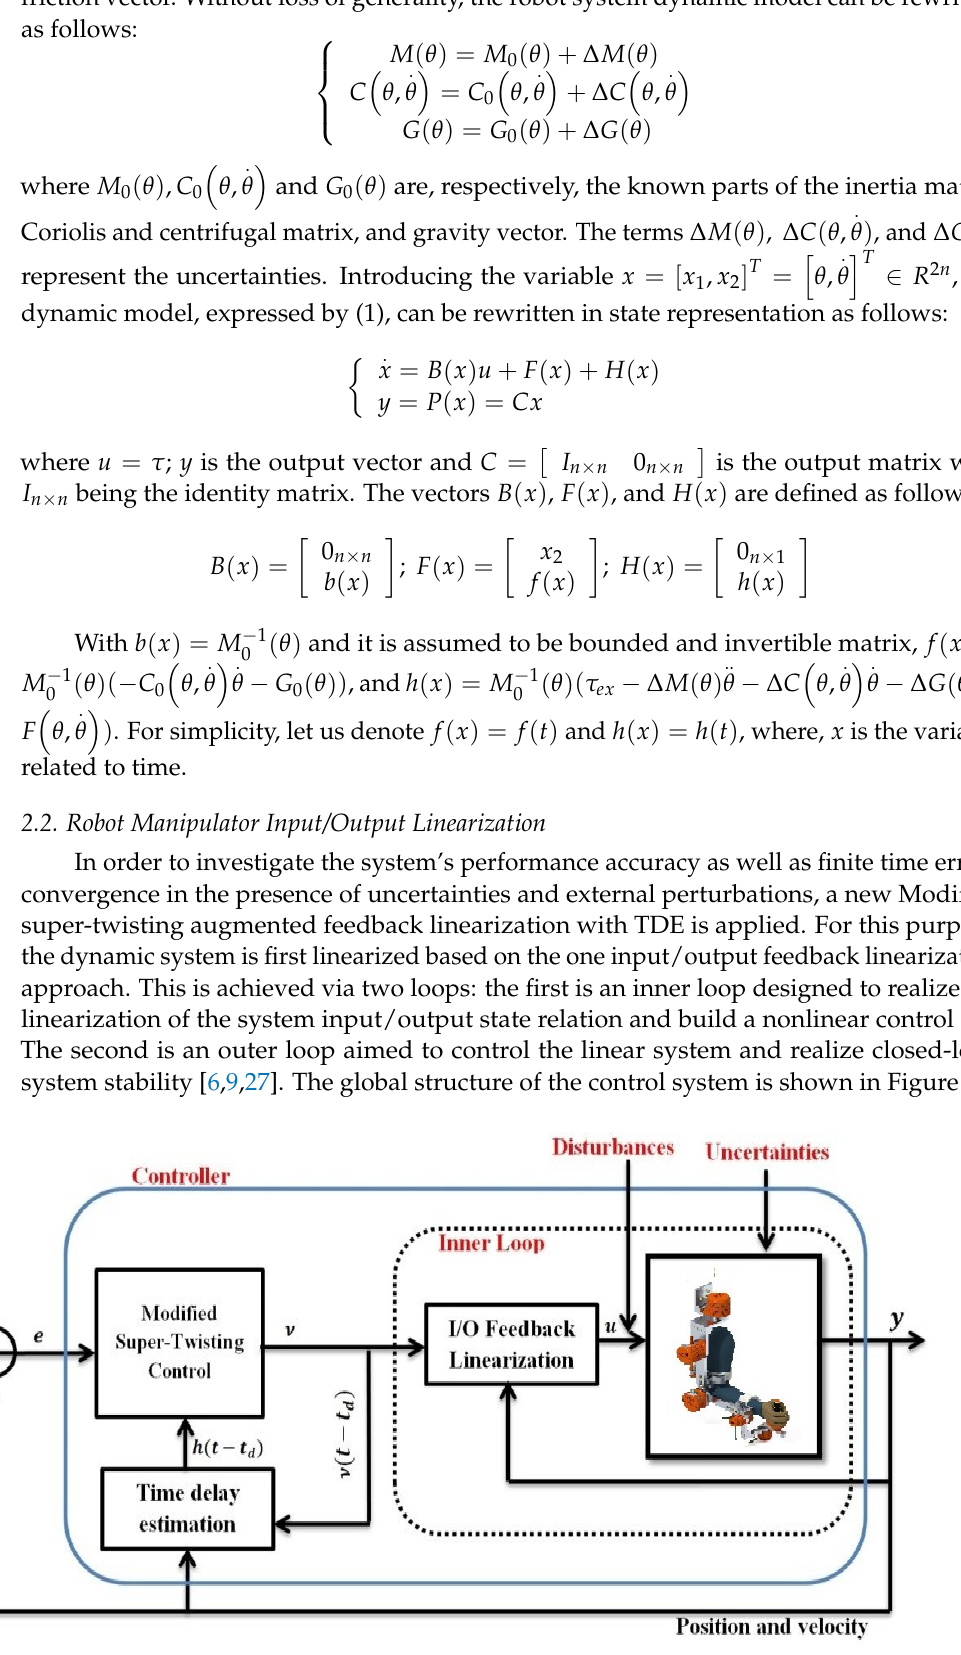
Figure 1. Block diagram of the proposed controller.